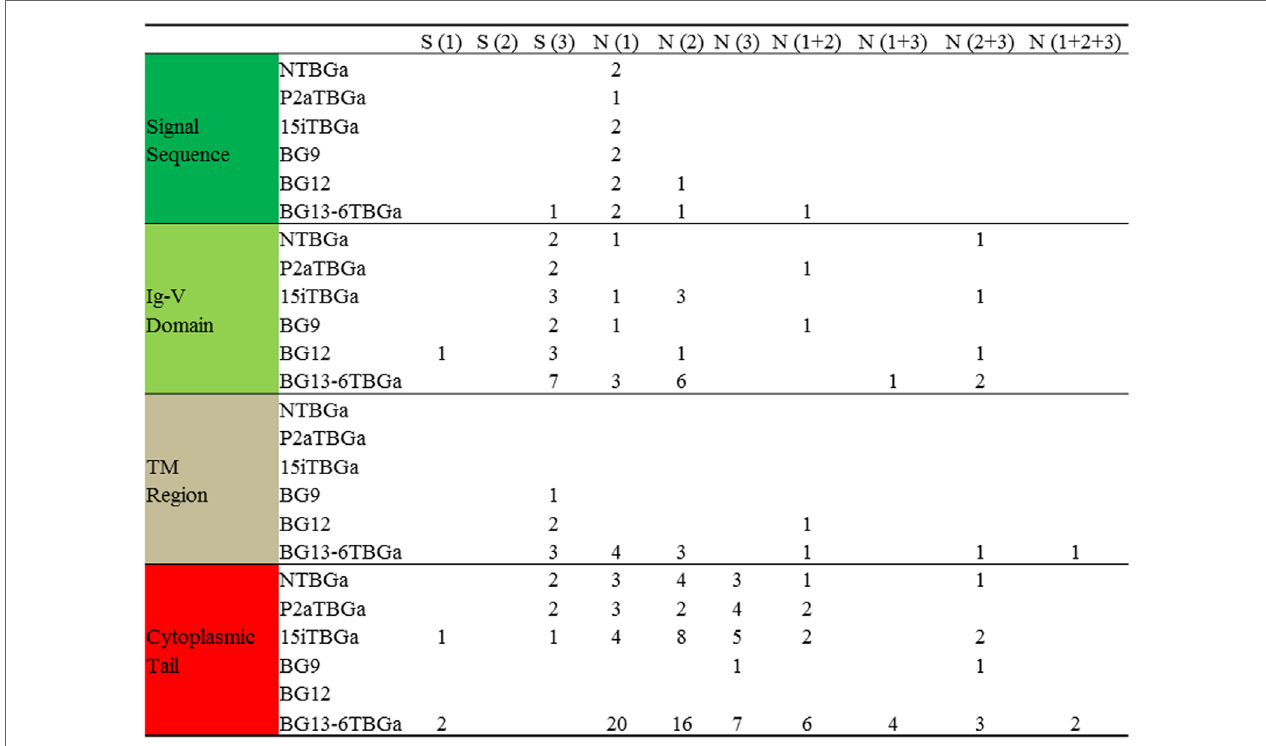
FigUre 6 | Compared with BG8 of the B12 haplotype, the number of silent and replacement changes by codon position for the “(nearly) full-length conceptual transcripts” (i.e., exons without introns) of the dominantly expressed genes from four chicken lines identified in this paper, and of the other appropriate BG genes (BG9, BG12, and BG13) of the B12 haplotype from Ref. (24). Names of the transcripts follow the convention: abbreviated line name, “T” for T cells, “BG” and the letter “a” representing the most frequently detected clone from the most frequently detected exon 2 sequence. Names of the genes follow the convention “BG” and the number of the gene locus from the B12 haplotype. Values are based on the alignments in Figure S4 in Supplementary Material, and amino acids from split codons at the edges of the exons are assigned to the exon with two of the three nucleotides of the codon (for instance, last amino acid of the signal sequence is assigned to the Ig-V domain, which in fact starts with glutamine in the mature